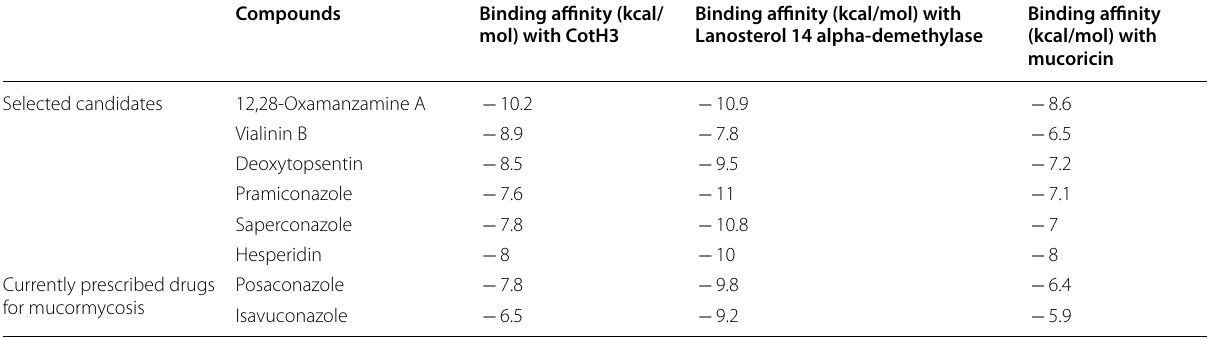
Table 10 Comparison of docking results between currently prescribed drugs and selected bioactive compounds against three target